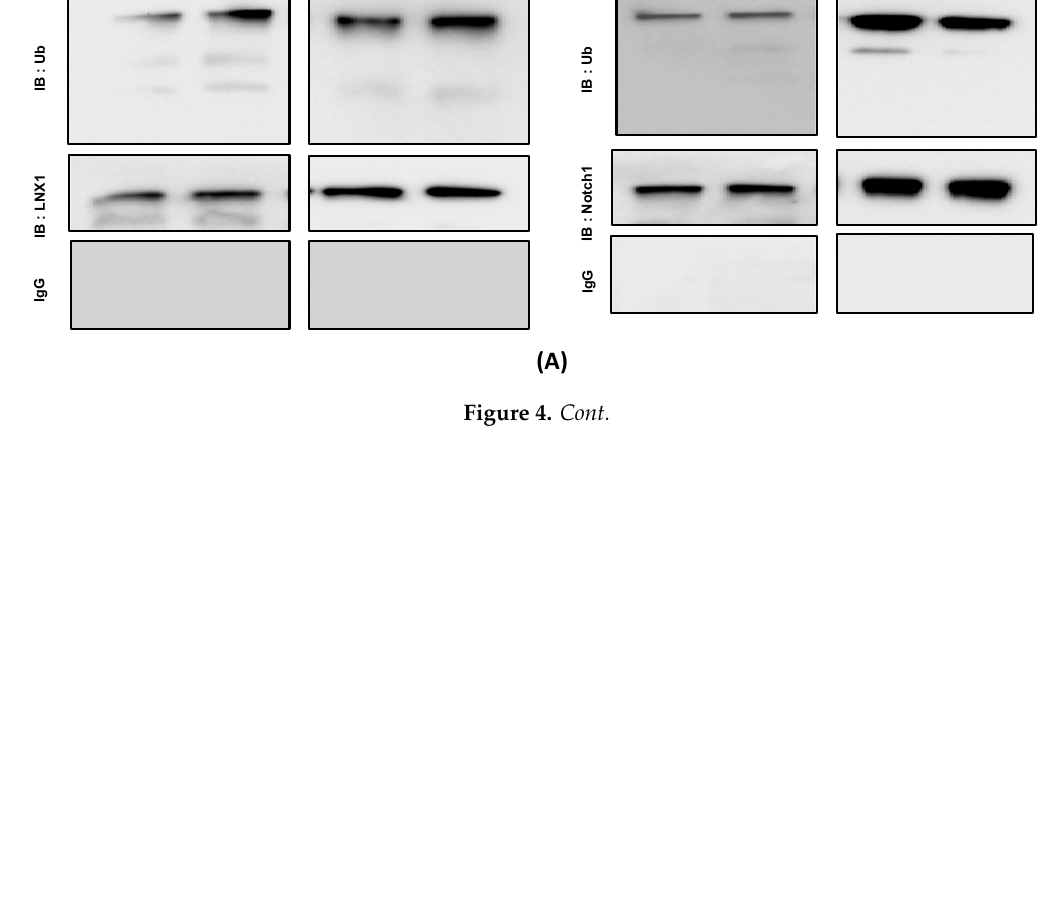
Figure 4. LNX – Numb and Numb – Notch1 interactions were upregulated after TMZ therapy. ( A ) An intraperitoneal (IP) injection was performed for LNX1 in GBM6 and GBM43 cells. Samples were then probed for Numb and Ubiquitin. An increase in Numb – LNX interactions and an increase in LNX – Ubiquitin interactions were noted after TMZ therapy, compared to the DMSO control. An additional IP injection was performed for Notch1 and samples were probed for Numb and ubiquitin levels. A mild increase was noted for Notch1 – Numb interactions. IgG controls were performed for all IP injections. ( B ) GBM43 and GBM6 cells were implanted in mice, following our mouse model for intracranial tumors. Tissue samples were isolated from these mice were then stained for LNX1 and Notch1 expression. The tumor area was imaged and colocalization analysis was performed for LNX1 and Notch1 expression. Results showed that LNX1 and NICD colocalization was significantly